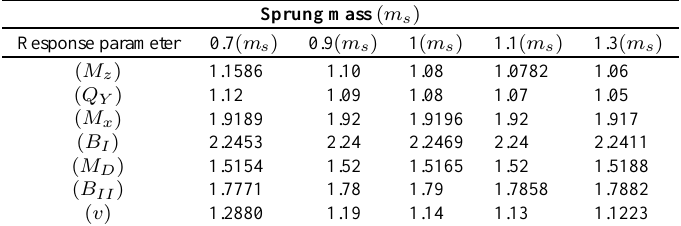
Table 10 Effect of sprung mass ( m s ) on impact factor